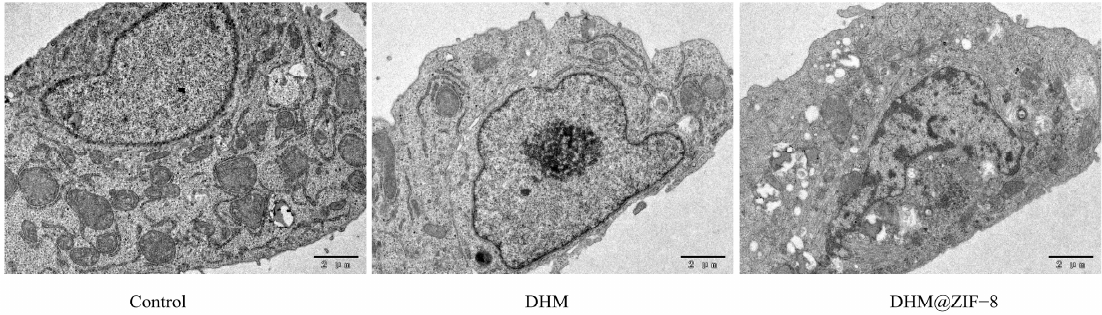
Figure 8. Cell morphology after treatment with DHM or DHM@ZIF-8. Scale bars = 2 µm.